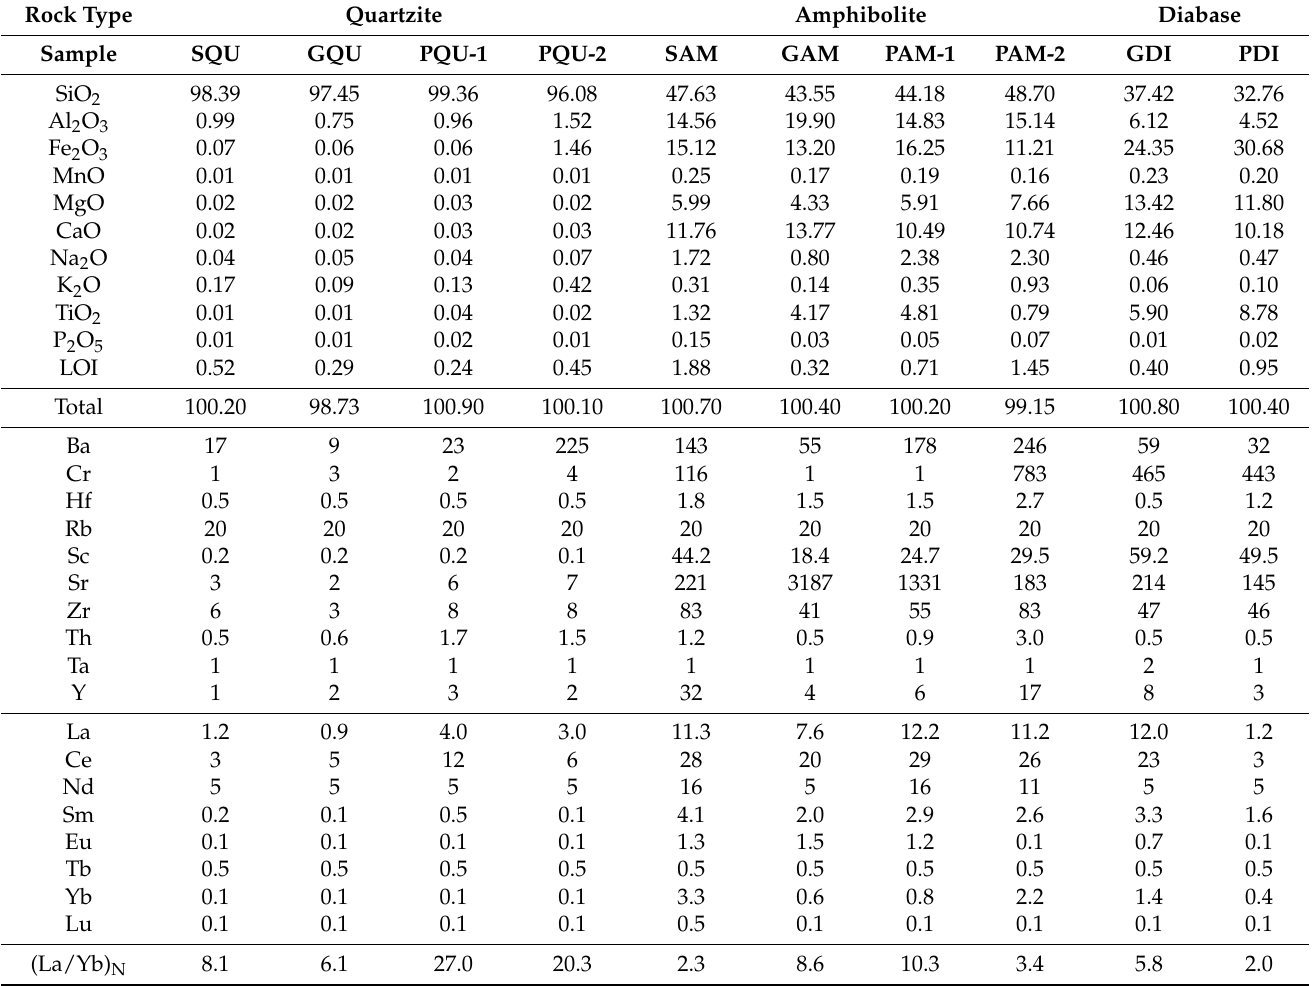
Table 4. Geochemical compositions of major oxides(wt.%) and selected minor and rare-earth ele- ments(ppm) for quartzite, amphibolite, and diabase. Sample names are as used in Table 1. LOI; loss on